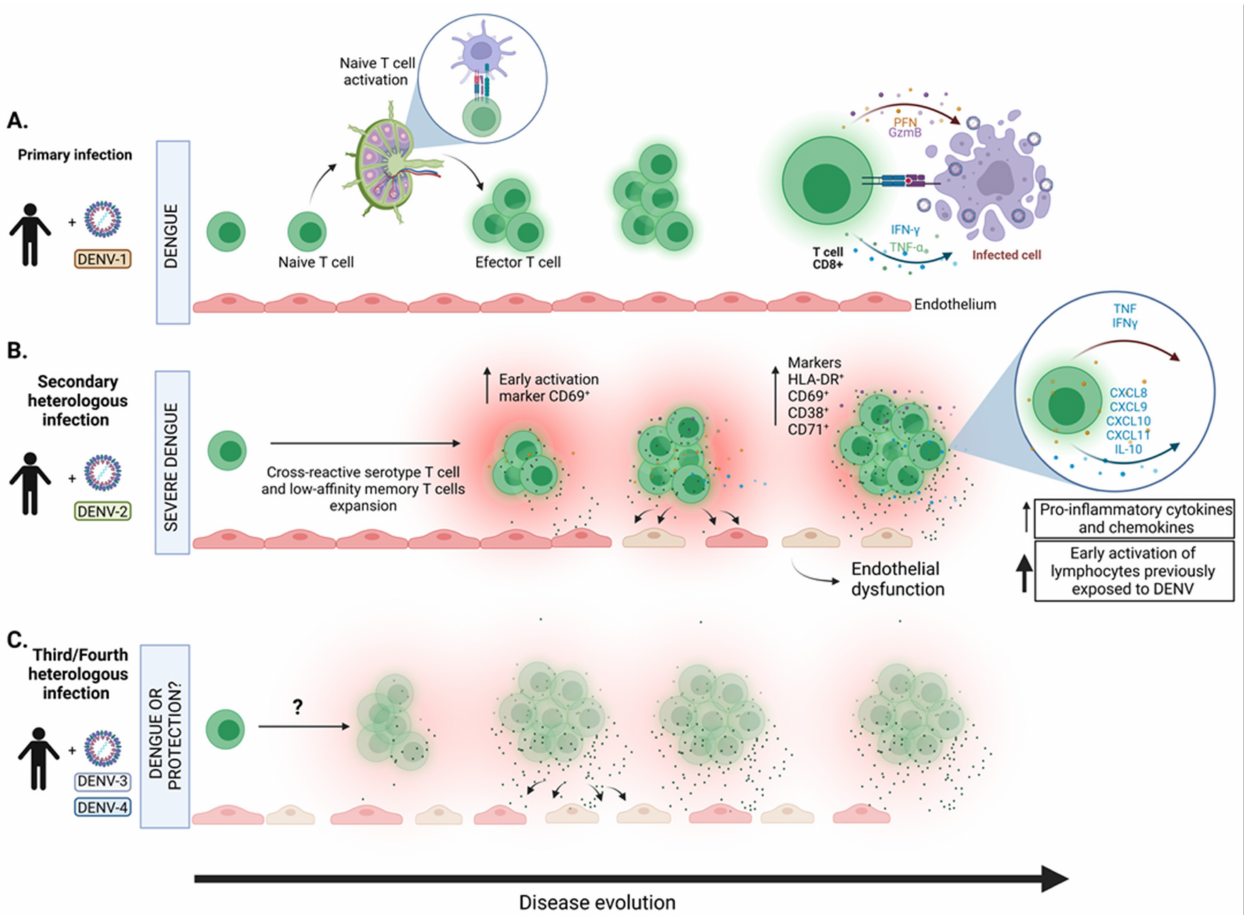
Figure 1. T cell response during DENV infection. History of exposure to dengue virus (DENV) is one of the factors that drive the T cell response in the evolution of the disease. ( A ) During primary infection, naïve T cells differentiate into effector T cells, leading to clearance of infection by direct lysis or by releasing antiviral cytokines, such as IFN- γ and TNF- α . ( B ) During a secondary heterologous infection, a robust immune response is developed by the early activation of cross-reactive serotype T cells, which produce abundant proinflammatory cytokines and chemokines, leading to excessive inflammatory environment, causing endothelial dysfunction that could trigger vascular permeability. ( C ) During a third or fourth heterologous infection, the activation of cross-reactive serotype T cells and their role in the severity or protection against infection is largely